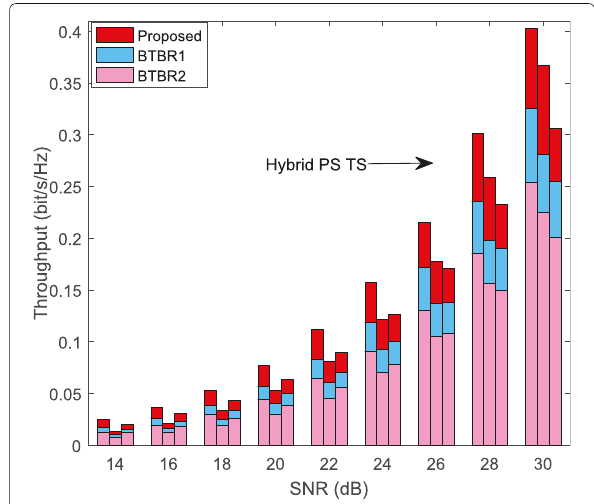
Fig. 6 Throughput performance of different protocols versus transmit SNR, d SR = 2 m, N = 3